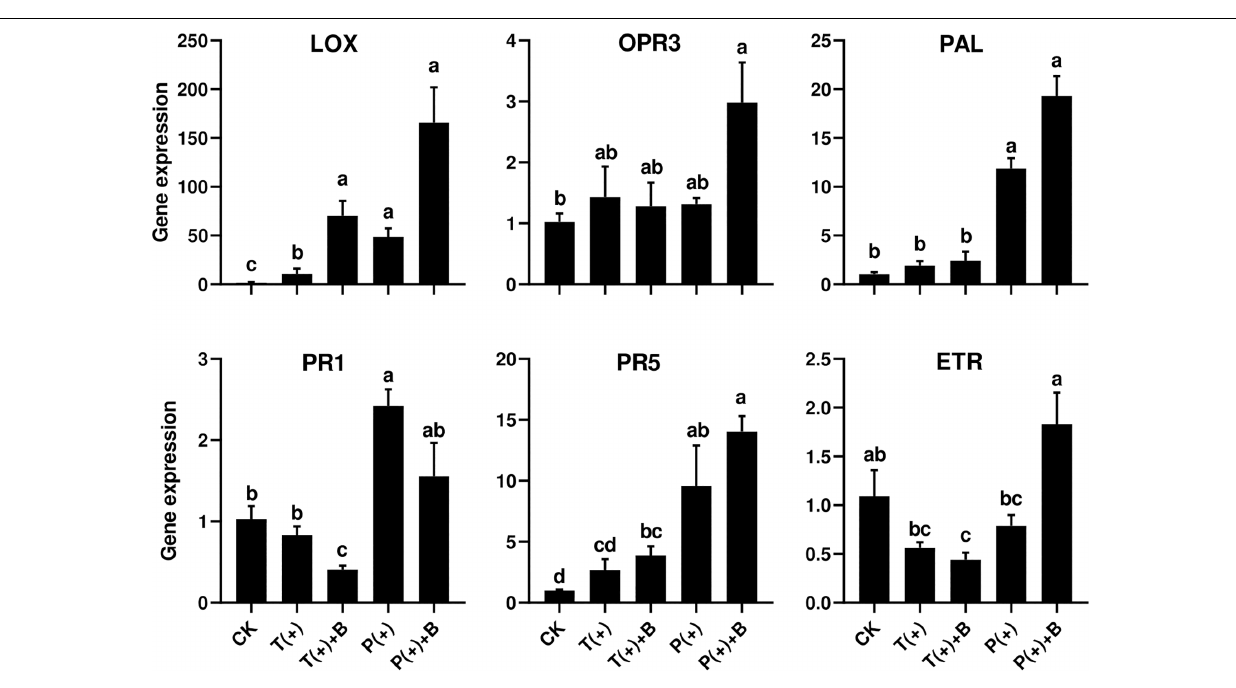
FIGURE 4 | Effect of pre-infestation of T. cinnabarinus and P. solenopsis on the expression levels of LOX , OPR3 , PAL , PR1 , PR5, and ETR genes in leaves of different combinations. Different letters above bars indicate significant differences in the quantities between control and treatment (ANOVA, P <